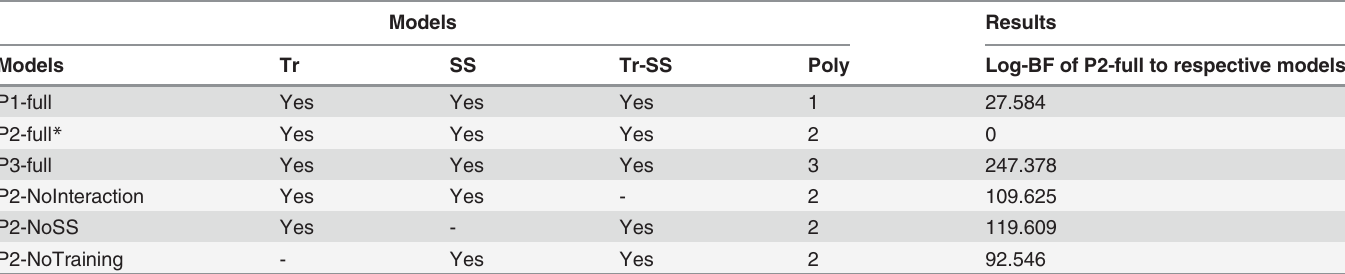
Table 1. Summary of the Bayesian hypotheses testing.